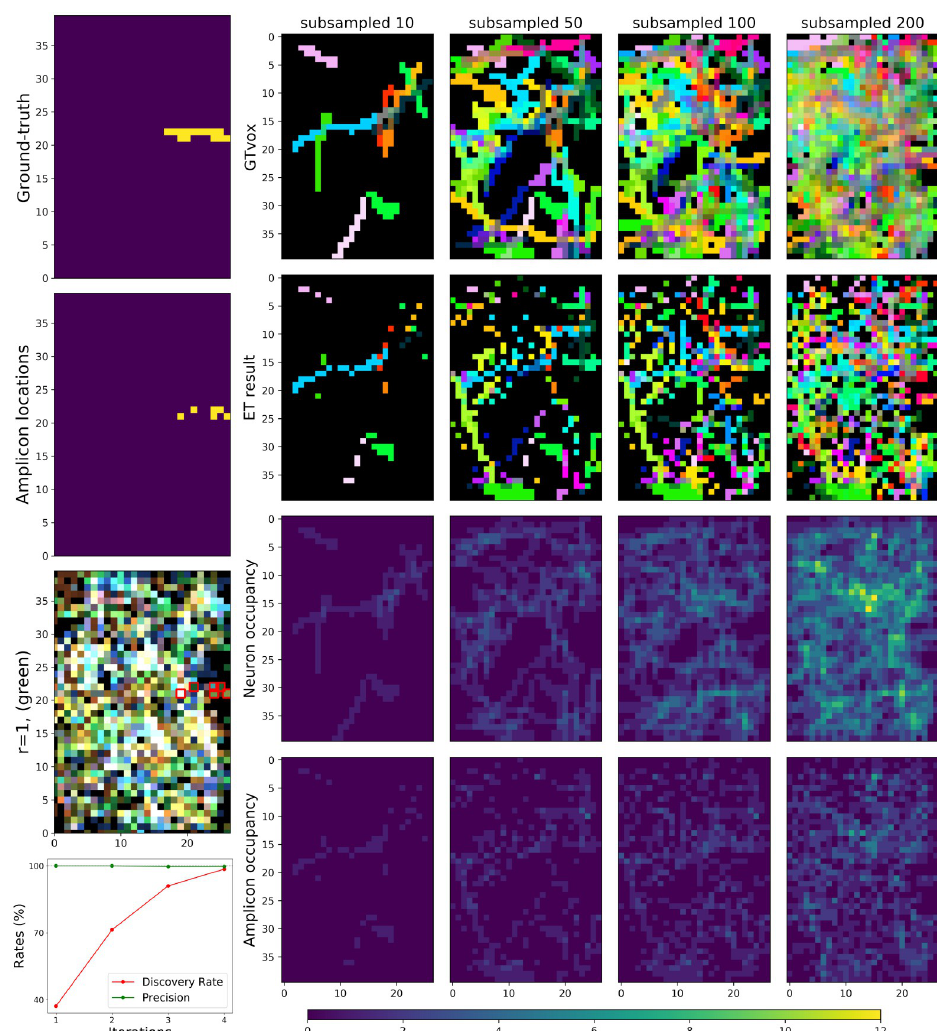
Fig 10. Limited optical resolution in low-resolution simulations yields signal mixing between neighboring neurons, but barcode discovery is still possible through an iterative process. Left, from the first to the third row : We show an example of one neuron. From the first to the third row: ground-truth morphology of the neuron; simulated amplicons; the image slice at the first imaging round. The red squares on the third row highlight true amplicon locations for a selected neuron, corresponding to the second row. Green fluorescence signal would be expected for the voxels containing amplicons with this neuron’s barcode in the first imaging round, but other colors are also present in these voxels due to contributions from other neurons. Bottom Left : The Discovery Rates (DR) result of the iterative barcode discovery process described in S1A.2.2 Appendix. As we proceed through more iterations, the precision remains essentially 100% but many new correct barcodes are discovered. Four iterations were sufficient to find all the barcodes in this low-resolution simulations data. Right : Details of the simulated low-resolution data. The neurons are highly overlapped in this data, so for visualization purposes we here show the results after subsampling the 412 neurons present in the data. Each column corresponds to a different number of subsampled neurons, and the number of randomly selected neurons are indicated in the title of each column. The first two rows show the ground-truth neuron segments and the evidence tensor (thresholded at 0.1, see S1 Fig for details on the choice of this threshold) for the same neurons. As in Fig 8, each neuron segment is plotted with a distinct color. Note that the evidence tensor roughly captures the neuronal morphology shown in the first row. The last two rows show the number of overlapping ground-truth neuron segments and the number of amplicons for these neurons for each voxel; note the high degree of overlap.